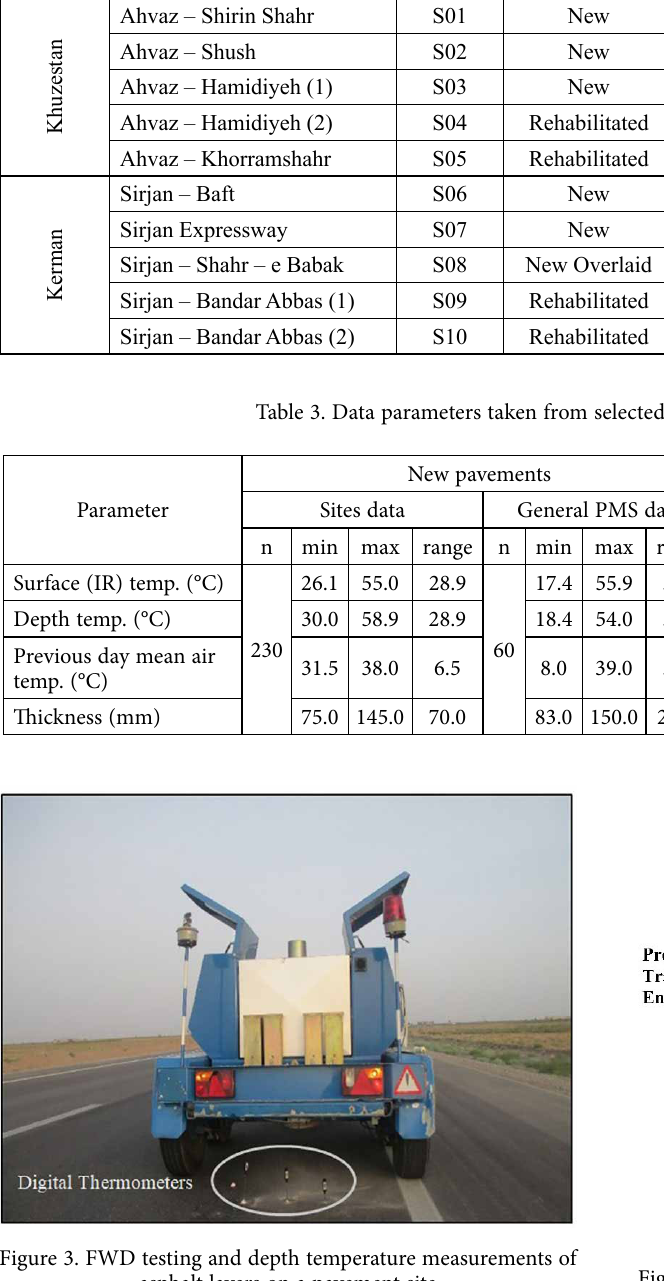
Figure 4. Detailed configuration of thermometers in depth of asphalt layers 290 sets for new pavements and 286 sets for rehabilitated pavements. Table 3 reports the two sets of the data sepa- rately for new and rehabilitated